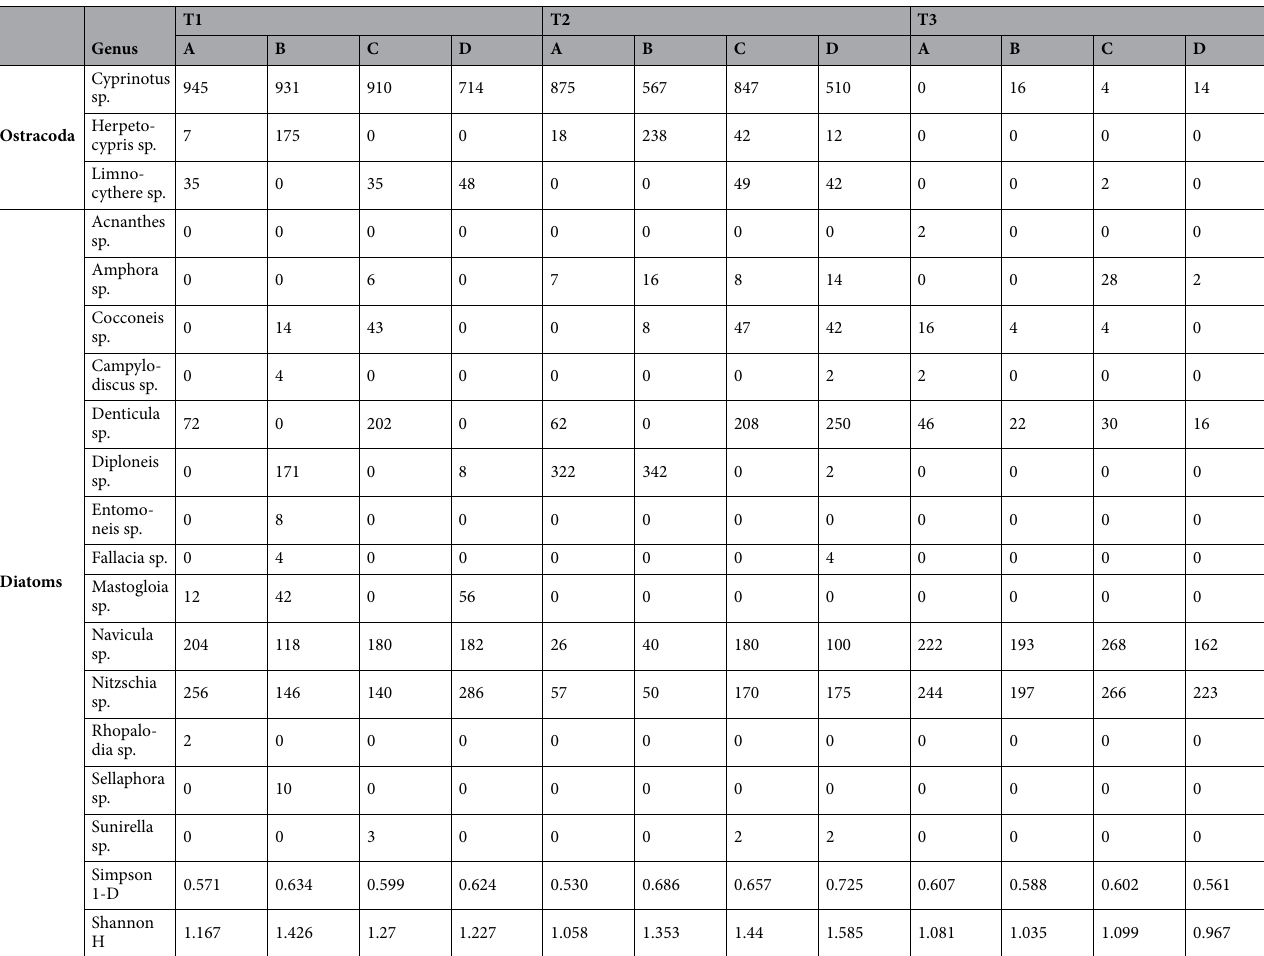
Table 3. Abundance of Ostracoda and diatoms identified, and community indices calculated from Salar de Tara samples.